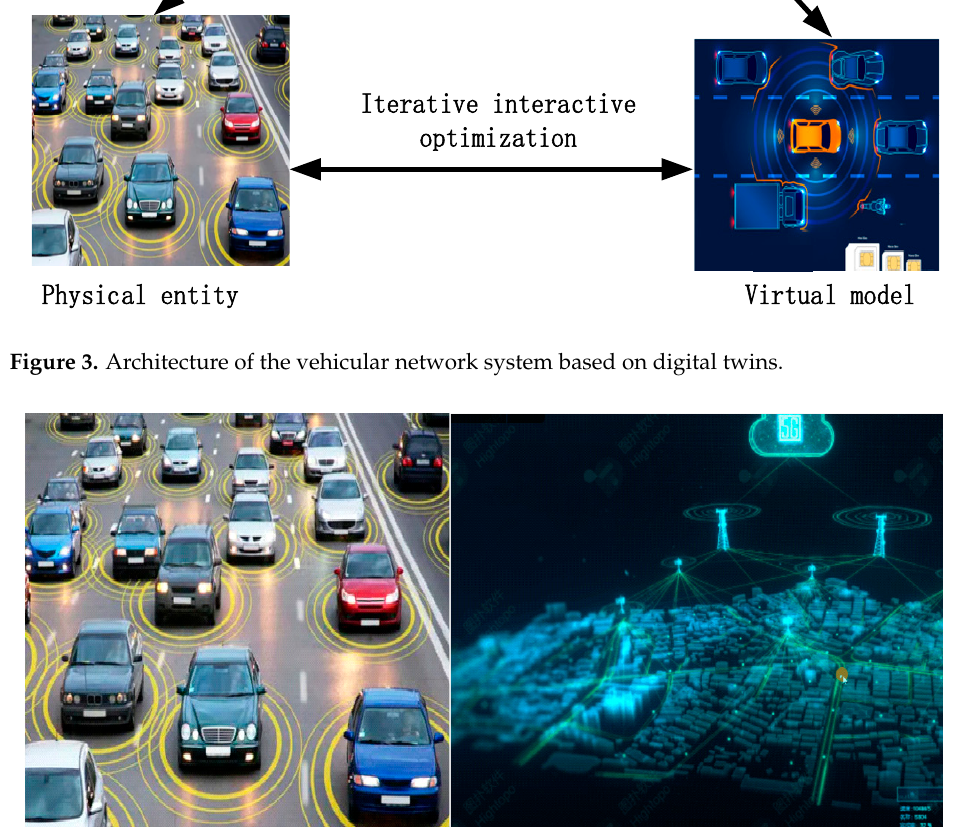
Figure 4. Physical world and digital twins.